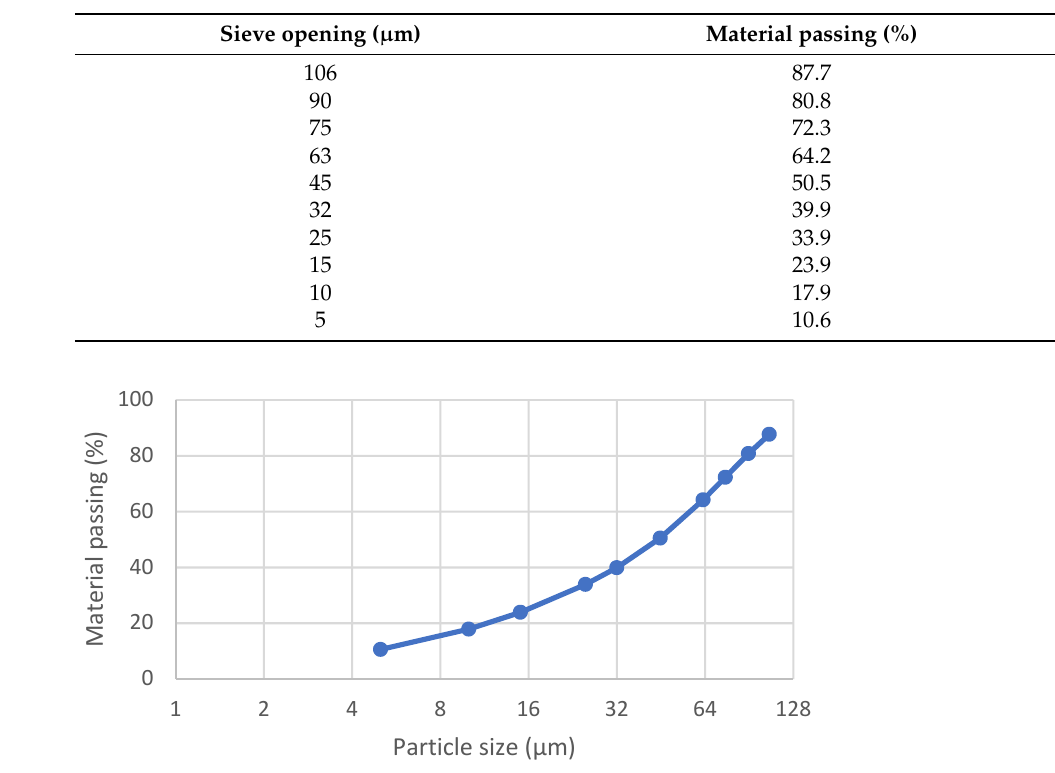
Figure 3. Laboratory flotation test flowsheet. The abbreviations for the test products shown in the flowsheet are Cu_RC: copper rougher concentrate, Cu_RT: copper rougher tailings, Cu_ScC: copper scavenger concentrate, Cu_ScT: copper scavenger tailings, Ni_RC: nickel rougher concentrate, Ni_RT: nickel rougher tailings and NiScC: nickel scavenger concentrate. Before starting the laboratory flotation test, process water pH was adjusted to 9.5 by lime addition. All tests were carried out at a temperature of 20 ˚ C. Prior to flotation, the test feed batch was ground in a laboratory mill at 70% solids for 27 min. The tests were performed using an Outotec GTK LabCell flotation machine with a 2 L flotation cell. The rotor mixing speed was 1300 rpm and air feed rate 5 NL/min. The slurry was first condi- tioned for two minutes with 35 g/t CMC, 5 g/t Aerophine 3418A and 20 g/t Nasfroth 240 reagents. After that, copper rougher-scavenger flotation was carried out for 10 min. Cop- per scavenger tailings were conditioned again with 15 g/t CMC, 50 g/t SIPX and 10 g/t Nasfroth 240 reagents for two minutes before recovering the nickel rougher concentrate during 7.5 min of flotation. After another conditioning of slurry with 30 g/t SIPX for two minutes, nickel scavenger flotation was performed for 7.5 min. 2.2. DAF Treatment The DAF treatment was conducted in a FlooDaf B5 container test unit. The pilot test system was equipped with a chemical dosing system, a compressor, and a local PLC (pro- grammable logic control) with online monitoring manufactured by Metso Outotec. The air to generate bubbles in the size range of 50 – 100 µm was fed to the system at 6 bar pres- sure. The surface area of the rectangular flotation tank was 5 m 2 . An inclined baffle was fixed 60 ˚ to the horizontal between the contact and separation zones to reduce turbulence and to elevate the bubble-floc agglomerates towards the surface of the tank. The capacity of the standard FlooDaf B5 unit is up to 35 m 3 /h. After optimizing the test conditions, the chemical dosages used were 90 ppm for cat- ionic coagulant PAX XL-100 and 1.3 ppm for anionic flocculant Superfloc A120 for the